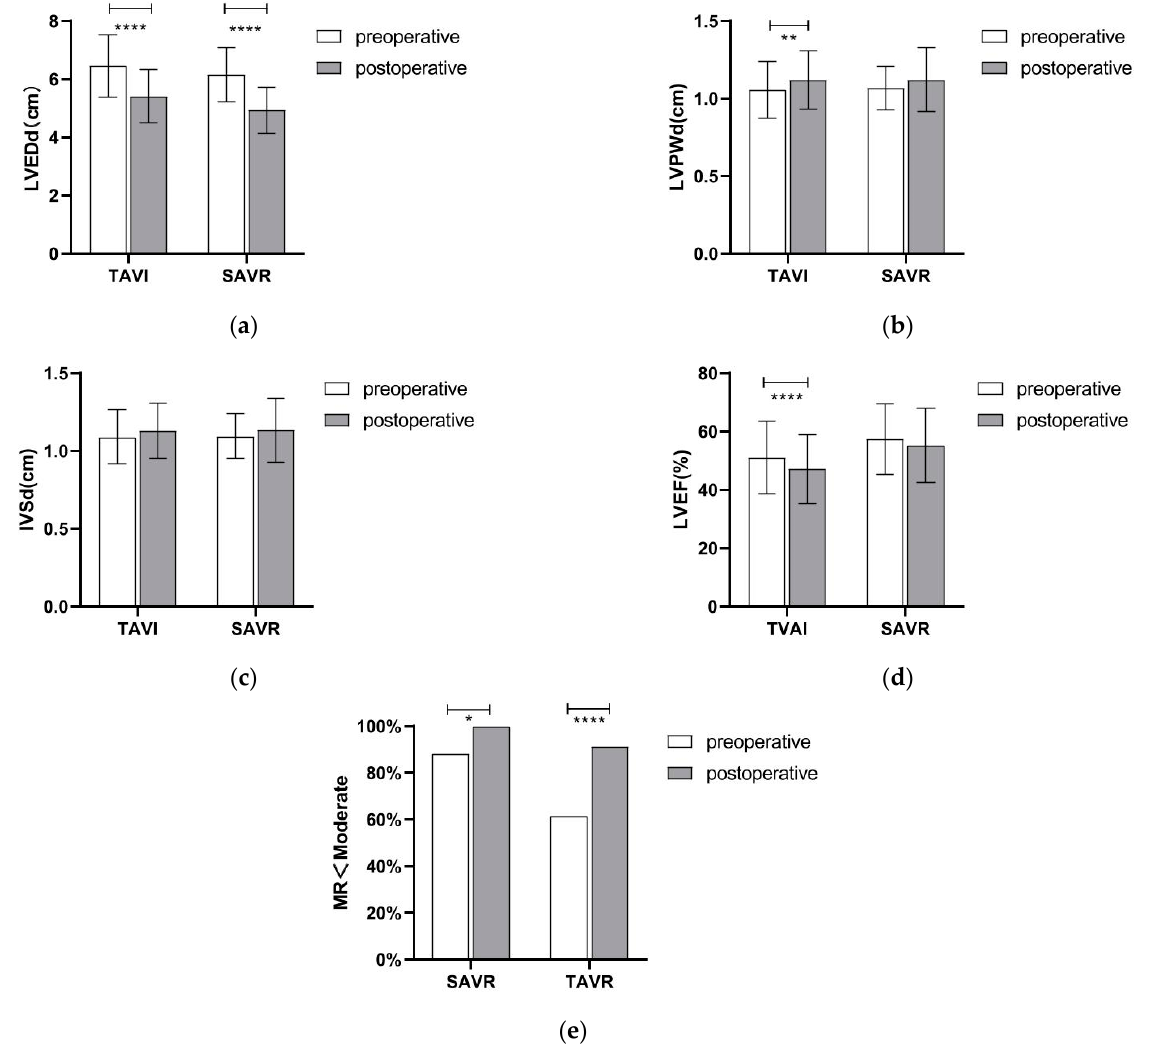
Figure 2. Cardiac ultrasound data changes in both groups before surgery and at 30-day follow-up: ( a ) LVEDd, left ventricular end-diastolic diameter; ( b ) LVPWd. left ventricle posterior wall daimeter; ( c ) IVSd, interventricular Septal diameter; ( d ) LVEF, left ventricular ejection fraction; ( e ) MR, mitral valve regurgitation. * means p ≤ 0.05, ** means p ≤ 0.001, and **** means p ≤ 0.0001.